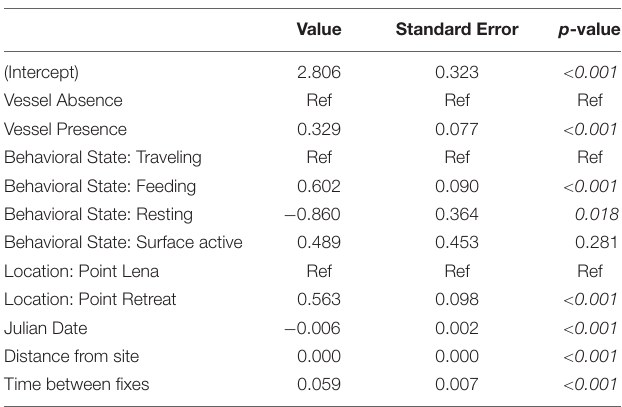
TABLE 5 | Estimated coefficients and standard errors from the AICc-best linear mixed effects model of the effects of vessel presence on log(Deviation) ( n = 2950 fixes) while controlling for behavioral state, location, Julian date, Beaufort sea state, distance from site, and time between